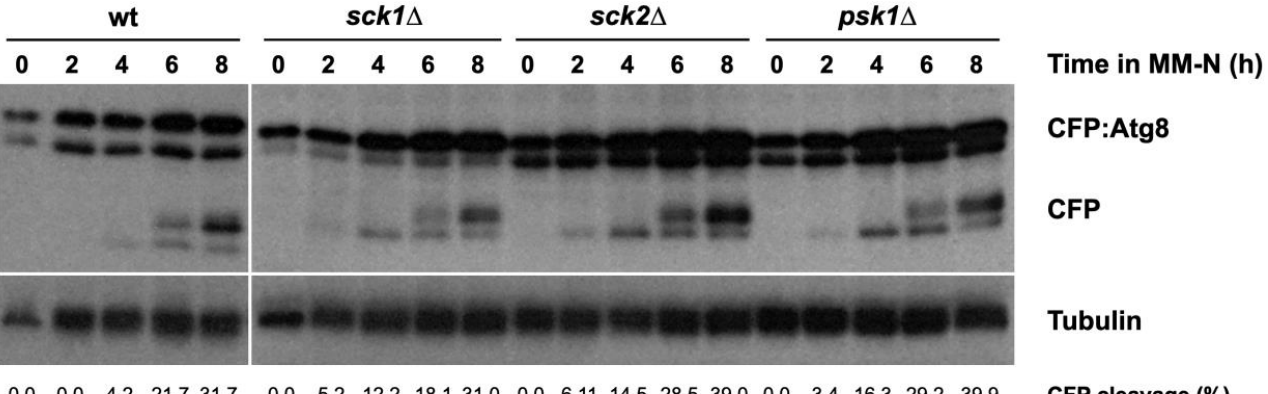
Figure 7. S6 kinases modulate autophagy. Wild type, sck1 ∆ , sck2 ∆ , and psk1 ∆ cells expressing CFP:Atg8 were grown in minimal medium at 25 °C until mid-exponential phase and then transferred to nitrogen-free minimal medium (MM-N) for 8 h at 25 °C. Samples were taken at 0, 2, 4, 6, and 8 h in MM-N. CFP:Atg8 and free CFP levels were determined using anti-GFP antibodies (Clontech). Tubulin was used as a loading control. The percentage of CFP cleavage is indicated under the gels.